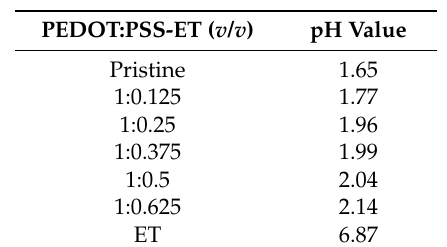
Figure 6. ( a ) PYS data of PEDOT:PSS and PEDOT:PSS-ET ( v / v , 1:0.5) films, normalized air-stability characteristics of BHJ-PSCs with ( b ) PEDOT:PSS and ( c ) PEDOT:PSS-ET ( v / v , 1:0.5) over 315 h of continuous testing. Table2. pH values of PEDOT:PSS and PEDOT:PSS-ET aqueous solutions.